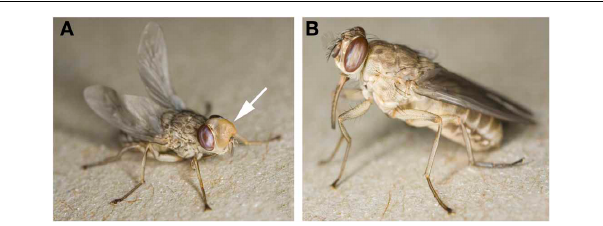
FIGURE 1 | Newly emerged “teneral” tsetse. (A) Glossina morsitans morsitans < 15min post-emergence from the puparium. The partially inflated ptilinum (marked by arrow) and unfurling wings are hallmarks for the youngest teneral flies. (B) Glossina palpalis palpalis < 2h post-eclosion. Note the pale body coloration, the ptilinal suture, weak legs, and fully extended wings. Images were used with permission from the photographer, Dr. Ray Wilson. http://www.raywilsonbirdphotography.co.uk/Galleries/Inverte